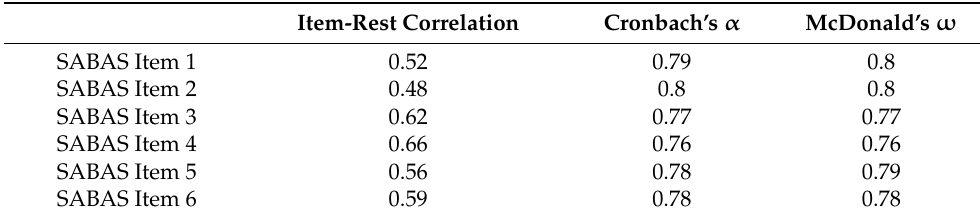
Table 4. Item-rest correlations and Cronbach’s α if an item is